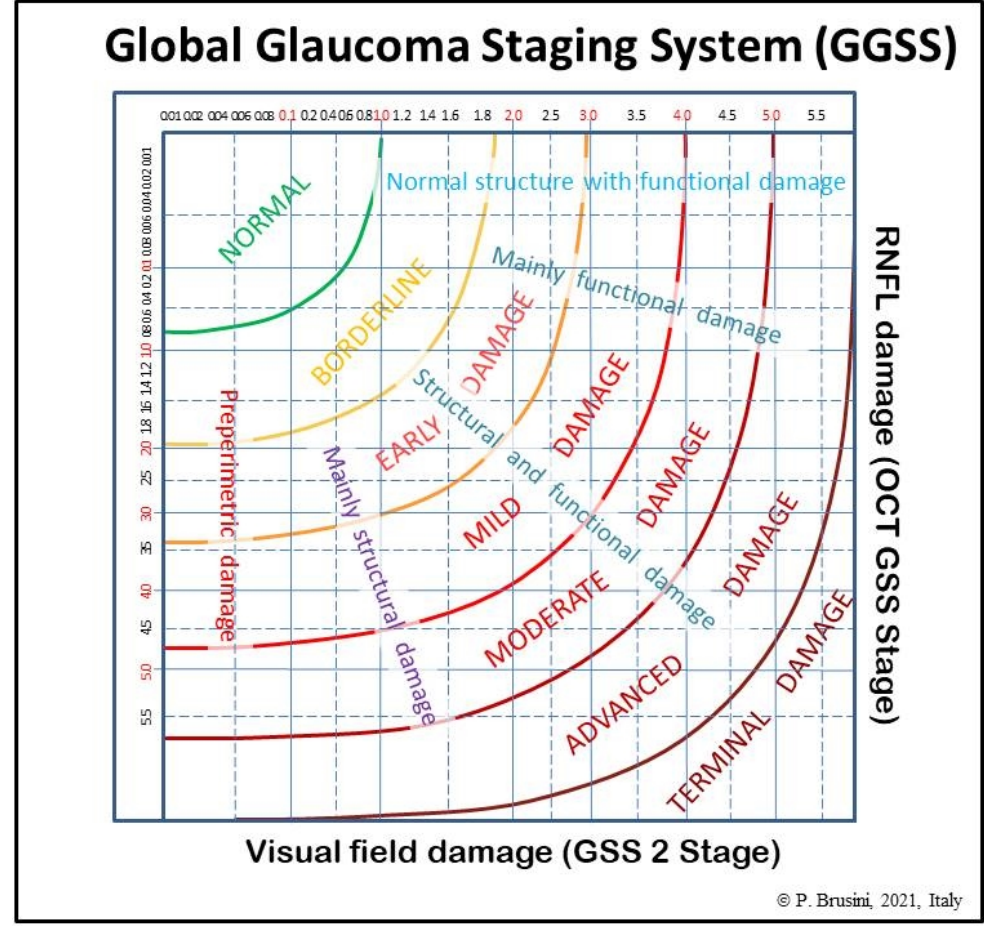
Figure 1. The global glaucoma staging system (GGSS). RNFL: retinal nerve fiber layer; OCT: optical coherent tomography; GSS 2: Glaucoma Staging System 2.